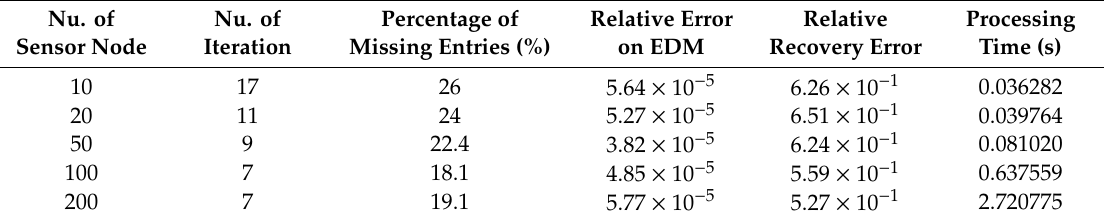
Table 2. Experimental results for 2-dimensional Wireless Sensor Network localization via Singular Value